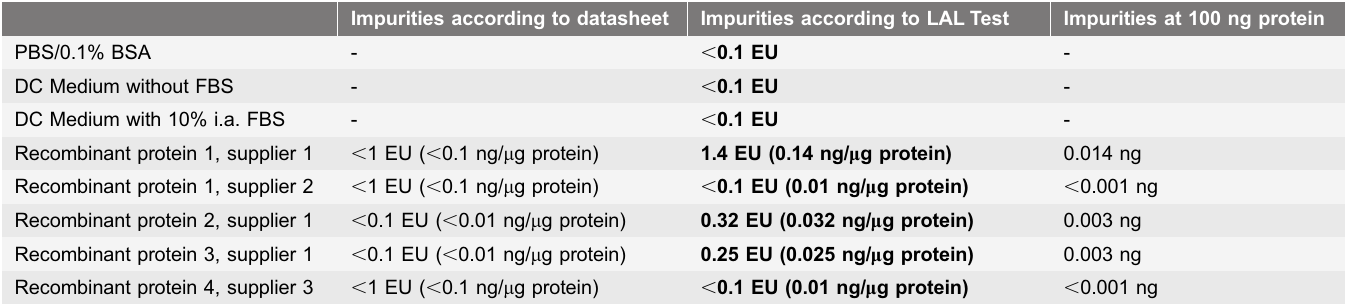
Table 1. Measured impurities in protein preparations from different suppliers evaluated by LAL